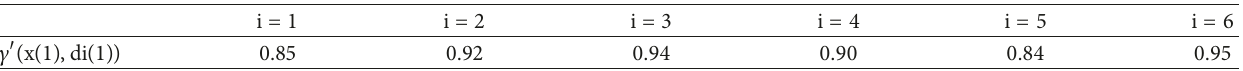
Table 9: Grey absolute correlations between Xiamen Port’s cargo throughput and its dry ports’ regional